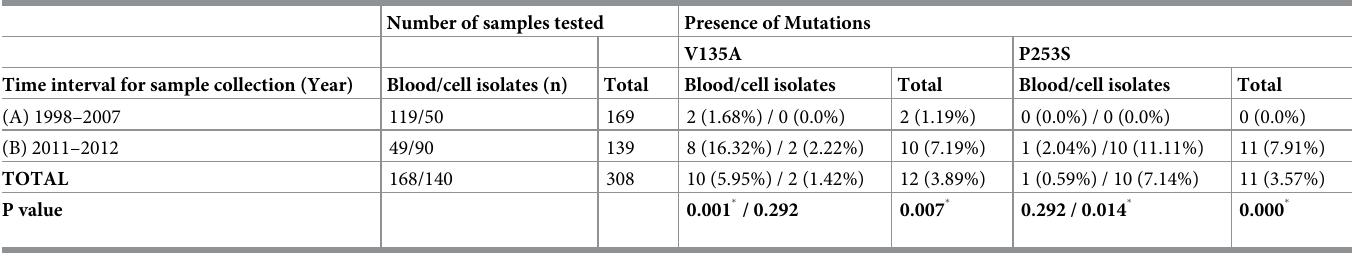
Table 5. Frequency of V135A and P253S mutations in independently collected T . annulata positive blood samples and